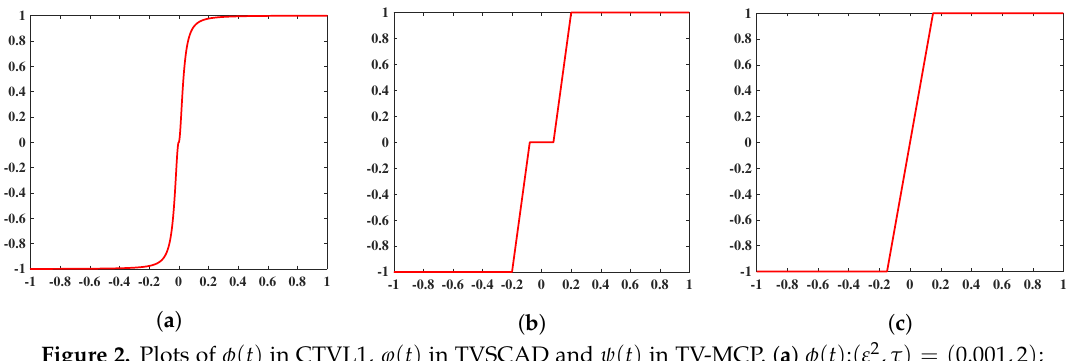
Figure 2. Plots of φ ( t ) in CTVL1, ϕ ( t ) in TVSCAD and ψ ( t ) in TV-MCP. ( a ) φ ( t ) : ( ε 2 , τ ) = ( 0.001,2 ) ; ( b ) ϕ ( t ) : ( γ 1 , γ 2 ) = ( 0.08,0.2 ) ; ( c ) ψ ( t ) : ( θ 1 , θ 2 ) = ( 1,0.15 )